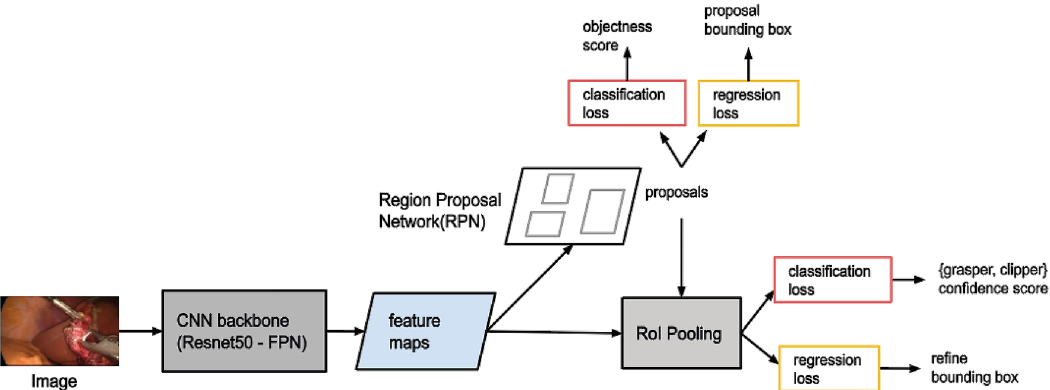
Figure 2. The Feature Pyramid Network (FPN) based Faster R-CNN fine-tuned with surgical instrument locations. The network receives an input of an image of arbitrary size. The backbone network is a Resnet50-FPN CNN which is connected to a Region Proposal Network (RPN) that shares its convolutional layers with the detection network. The RPN is a fully convolutional network which generates region proposals which are highly likely to contain an object. The detection network pools features out of these region proposals and sends them to the final classification and bounding box regression networks. The final output is a bounding box for each detected instrument and a class label (grasper or clipper) with its confidence